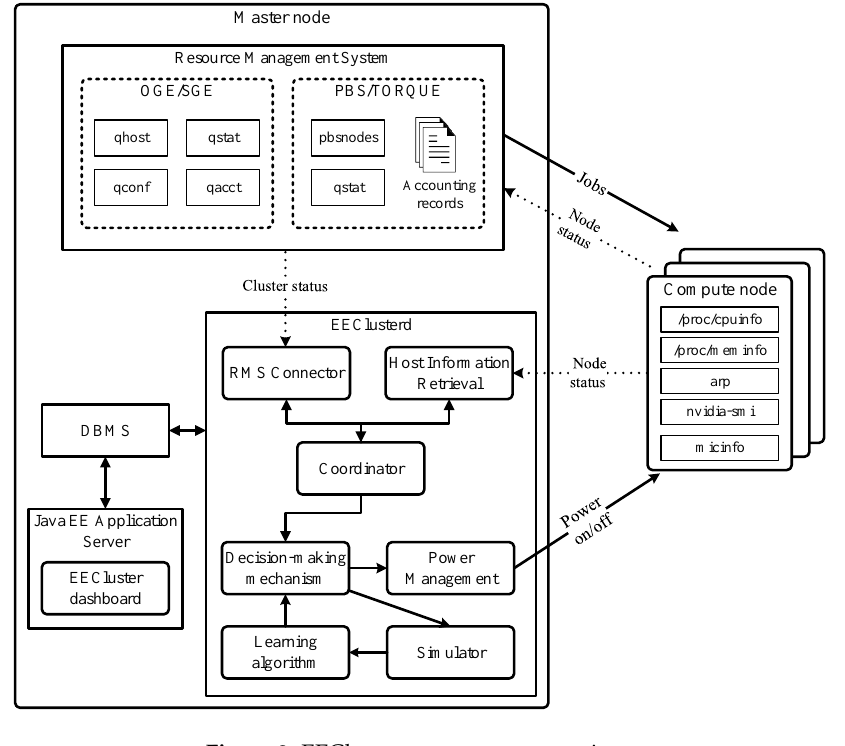
Figure 2. EECluster components overview.